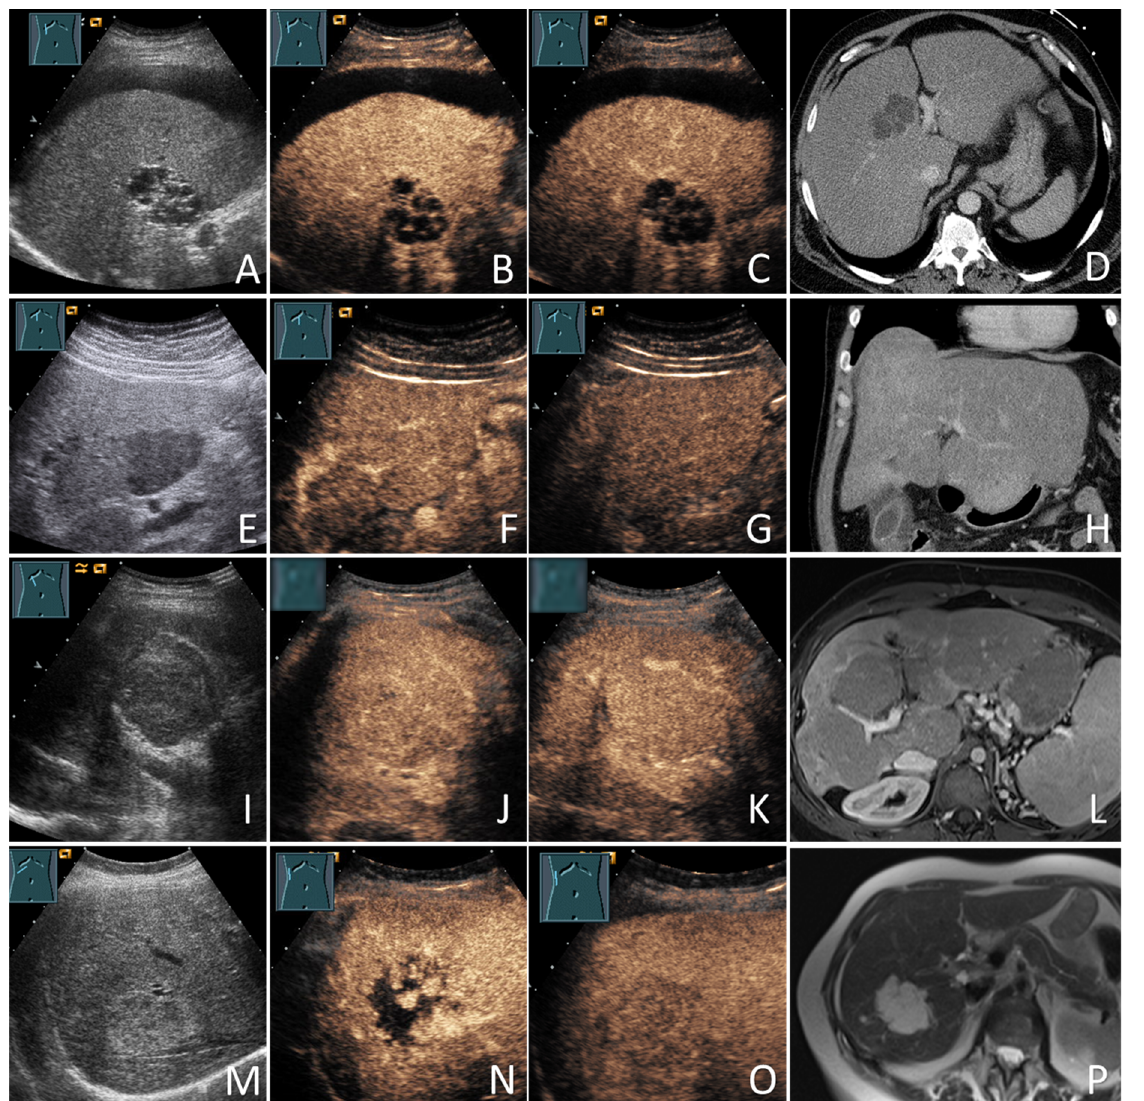
Figure 2. Benign focal liver lesions (bFLLs) in patients with liver cirrhosis (LC). Liver cyst ( A – D ): hypoechoic FLL with multiple septa on grey-scale ultrasound ( A ); hypoechoic FLL with arterial phase isoenhancement of the septa ( B ); hypoechoic FLL without washout in the delayed venous phase ( C ); the corresponding CT of the FLL (courtesy of Prof. Dr. Andreas H. Mahnken, Department of Radiology, University Hospital Marburg) ( D ). Focal fat sparing ( E – H ): hypoechoic FLL on grey-scale ultrasound ( E ); hypoechoic FLL with isoenhancement on the arterial phase ( F ); hypoechoic FLL with isoenhancement on the delayed venous phase ( G ); the corresponding CT of the FLL (courtesy of Prof. Dr. Andreas H. Mahnken, Department of Radiology, University Hospital Marburg) ( H ). Regenerative nodules ( I–L ): large central isoechoic lesion on grey-scale ultrasound ( I ); large central isoechoic lesion with isoenhancement on the arterial phase ( J ); large central isoechoic lesion with isoenhancement on the delayed venous phase ( K ); the corresponding MRI of the FLL (courtesy of Prof. Dr. Andreas H. Mahnken, Department of Radiology, University Hospital Marburg) ( L ). Hemangiomas ( M – P ): large central echogenic lesion on grey-scale ultrasound ( M ); large central echogenic lesion with nodular enhancement on the arterial phase ( N ); large central echogenic lesion with isoenhancement on the venous phase ( O ); the corresponding MRI of the FLL (courtesy of Prof. Dr. Andreas H. Mahnken, Department of Radiology, University Hospital Marburg) ( P ). The lesions remained stable over a follow-up period of over 92